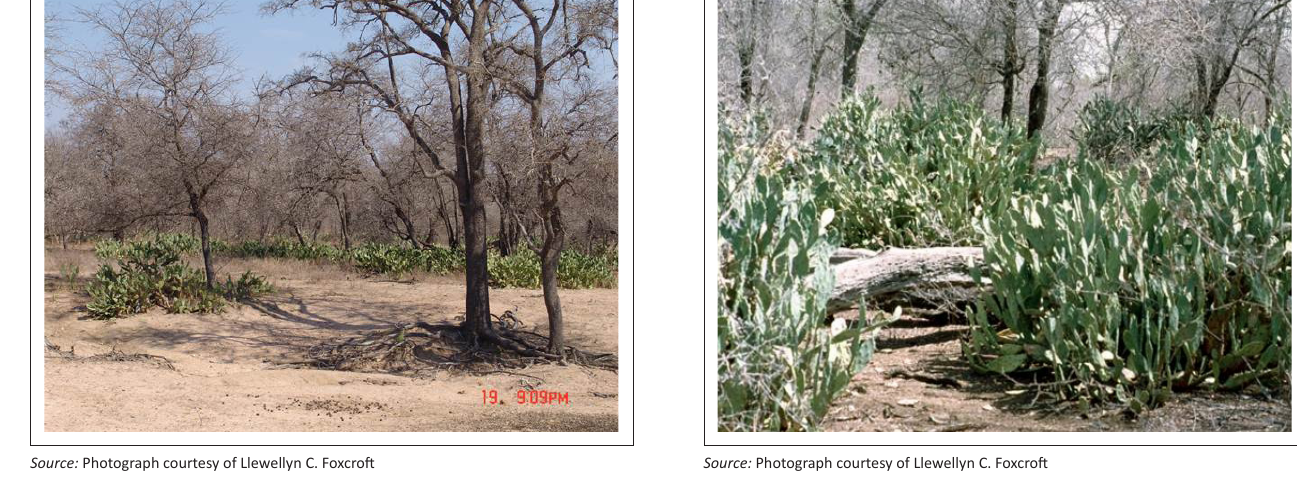
FIGURE 4: Invasion with more than 50 %